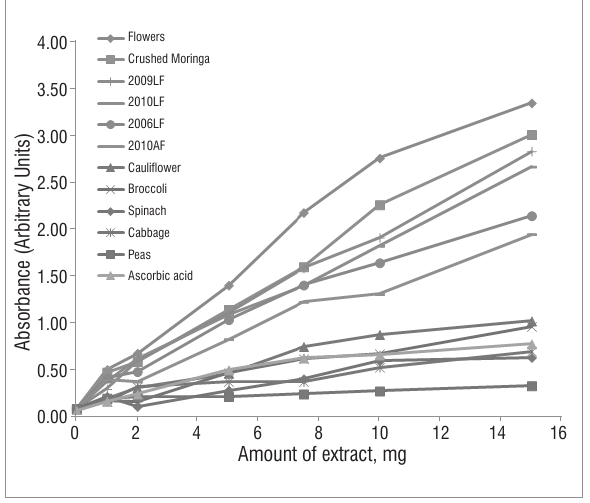
Figure 3: Reducing power of moringa and vegetable extracts ( p <0.05; n=3) and ascorbic